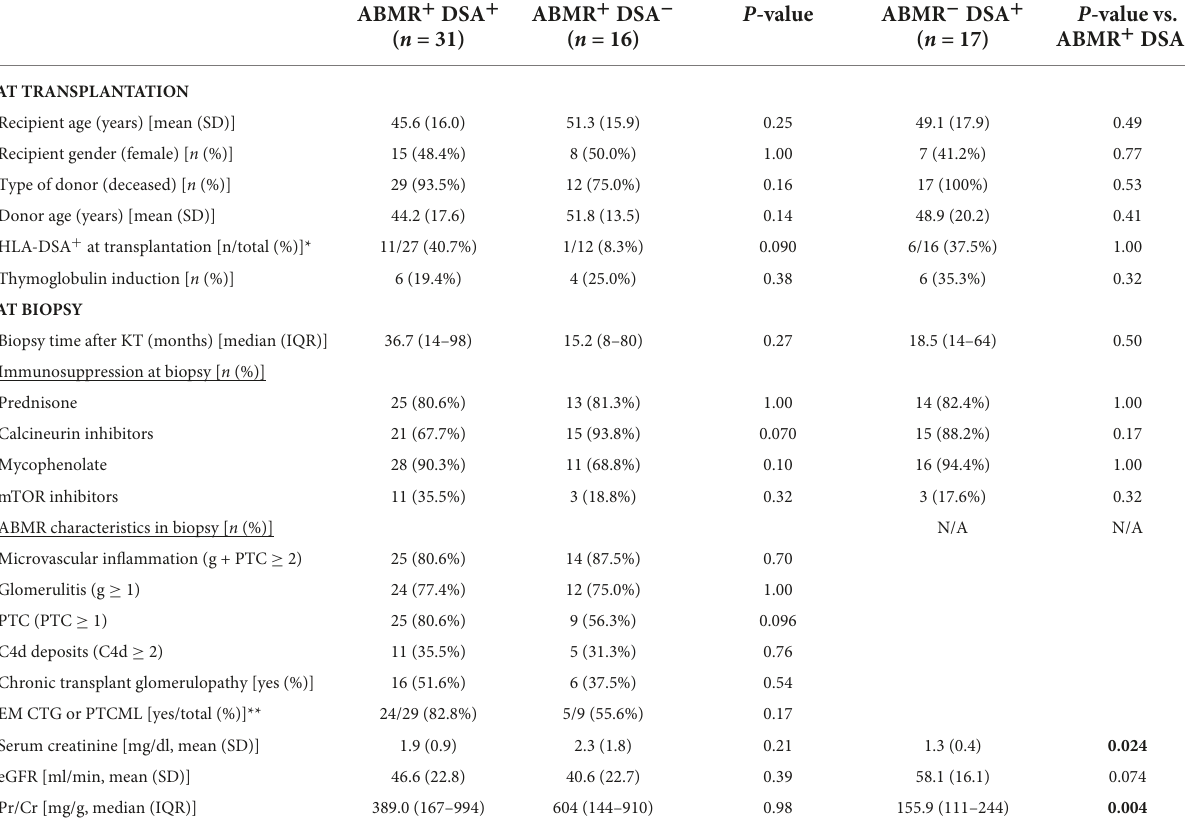
TABLE 3 Main demographic and clinical characteristics of patients with ABMR and DSA compared to ABMR without HLA-DSA (left) and to non-ABMR with HLA-DSA (right).